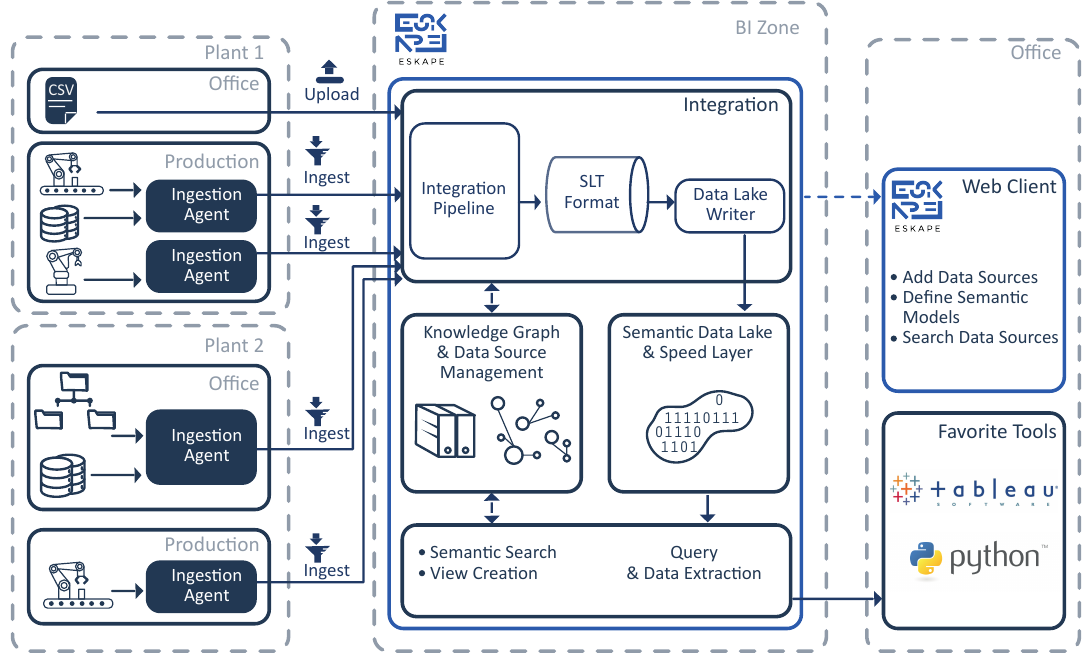
Figure 5. Overview about the overall architecture consisting of the data ingestion agents in the plants and the ESKAPE platform running in the Business Intelligence (BI)